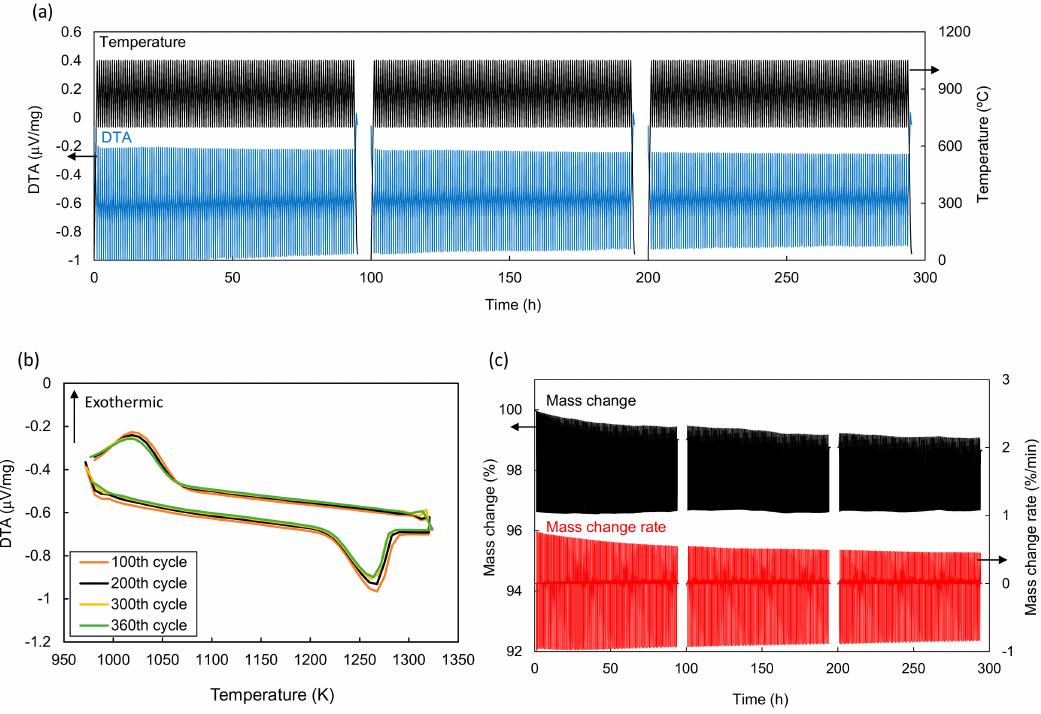
Figure 2. Long-term thermal stability of the HC–HD cycle with an oxygen partial pressure of P O = 0.168 bar for the sample: variations in the ( a ) DTA signal, ( b ) hysteresis curve, and ( c ) mass 2 change and mass change rate for the temperature